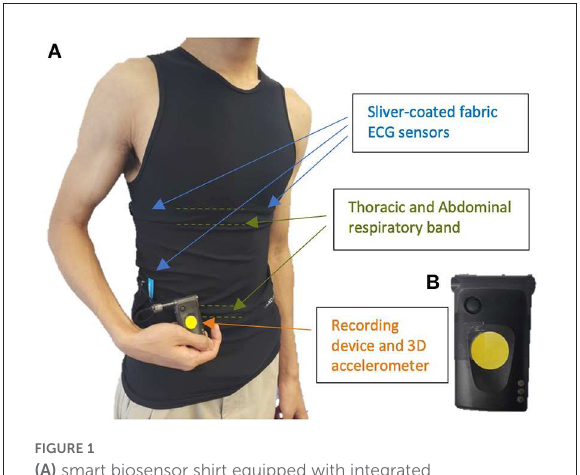
FIGURE1 (A) smart biosensor shirt equipped with integrated electrocardiogram (ECG), respiratory bands, and (B) detachable recording device with incorporated 3D